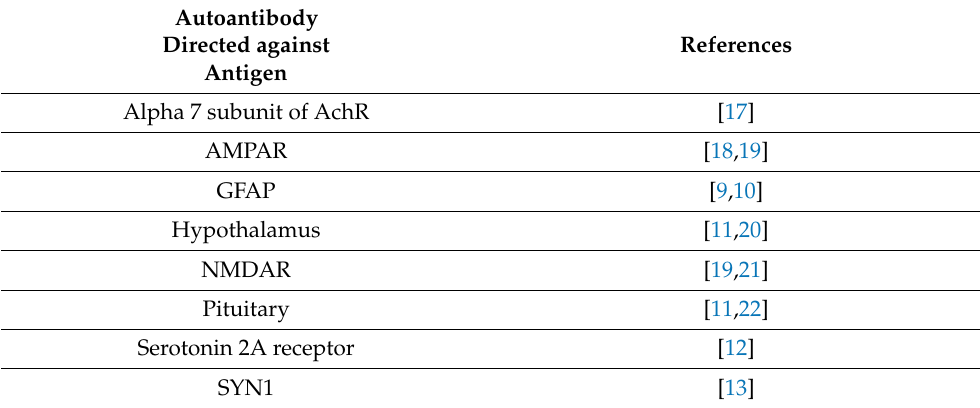
Table 1. Serum neural autoantibodies associated with brain